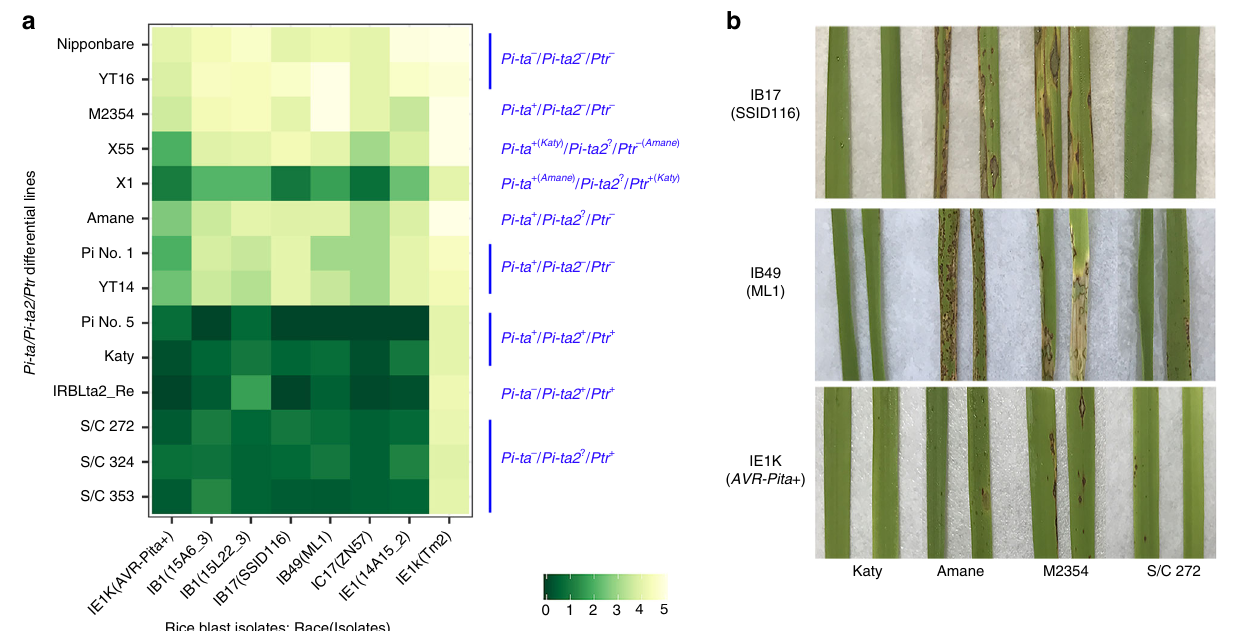
Fig. 3 Disease reactions of Pi-ta / Pi-ta2 / Ptr differential lines. a Disease reactions of Pi-ta / Pi-ta2 / Ptr lines to four diverse races/isolates. Disease reaction was evaluated 7 days post-inoculation with 0 – 5 rating scale where 0 – 2 is resistant and 3 to 5 is susceptible. Rice varieties with the Pi-ta / Pi-ta2 / Ptr genes were susceptible to IE-1K (TM2 lacking AVR-Pita ) and resistant or moderately resistant to the transformant IE-1K + AVR-Pita from O-137 15 . Note: M. oryzae races (isolates), IB-1 (15A6_3, 15L22_3), IB-17 (SSID116), IB-49 (ML1), and IE-1 (14A15 – 2), differentiated the Pi-ta -containing rice lines from the rice lines with Pi-ta2 / Ptr . b Photographs showing disease reaction of indicated rice lines and races: Katy ( Pi-ta + / Pi-ta2 + / Ptr + ), Amane ( Pi-ta + /Pi-ta2?/Ptr - ) and M2354 ( Pi-ta + / Pi-ta2 - / Ptr − ), and S/C272 ( Pi-ta − / Pi-ta2? / Ptr + ). Pictures were taken at seven days